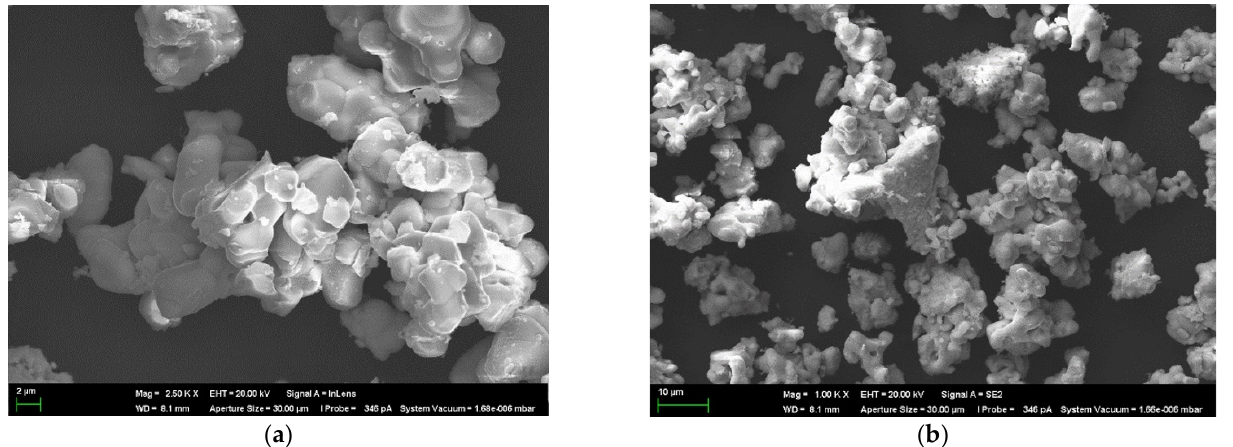
Figure 4. The SEM-images of the composition Ba 1.1 La 0.9 Y 0.5 In 0.5 O 3.95 ( a , b ) Table 1. The average element ratios determined by EDS analysis for the sample Ba 1.1 La 0.9 In 0.5 Y 0.5 O 3.95. Content of the Elements, Atomic % Element